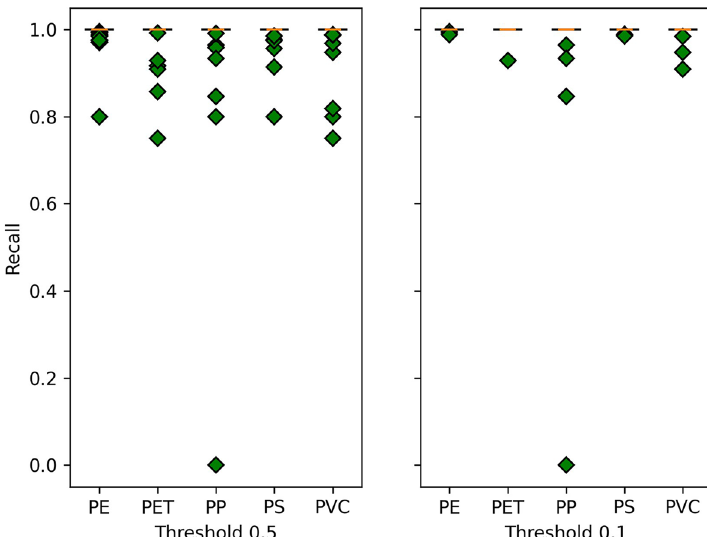
Fig. 9 Recall per sample, class, and